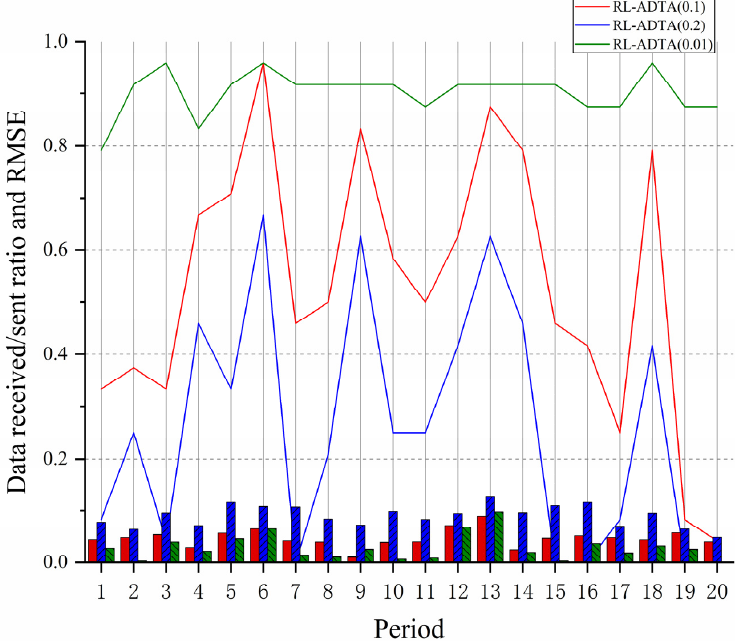
Figure 12. Analysis of transmission efficiency and accuracy of RL-ADTA (0.1, 0.2, 0.01). The colors of lines and histograms represent the type of algorithm. The ratio between the data actually received by the sink node and the data that need to be sent by the sensor node in each period is shown in the line chart. The lower the ratio, the smaller the amount of correction data received. The RMSE between the data recovered by the sink node according to the prediction parameters and correction data, and the data collected by the sensor node in each period, is shown in the histogram. The smaller the RMSE, the higher the accuracy of the underwater monitoring application.